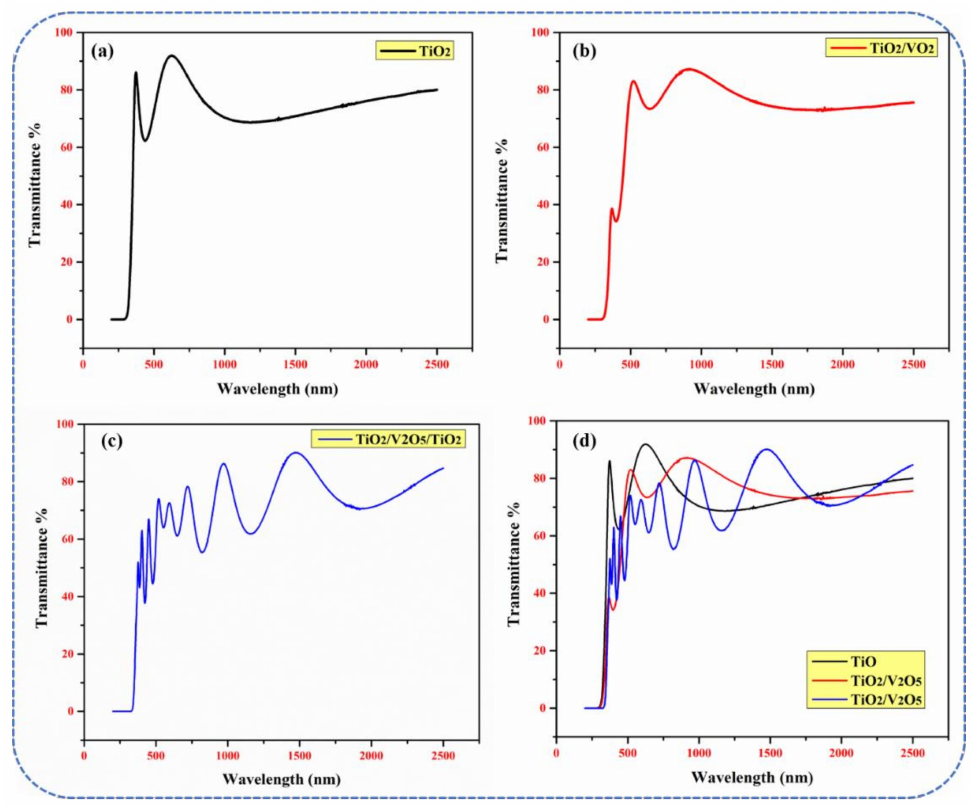
Figure 3. Transmittance spectra of ( a ) single-layer TiO 2 , ( b ) bi-layer TiO 2 /V 2 O 5 , and ( c ) multi-layer TiO 2 /V 2 O 5 /TiO 2 thin films; ( d ) the combination of spectra for the mono-, bi-, and multi-layer thin films,